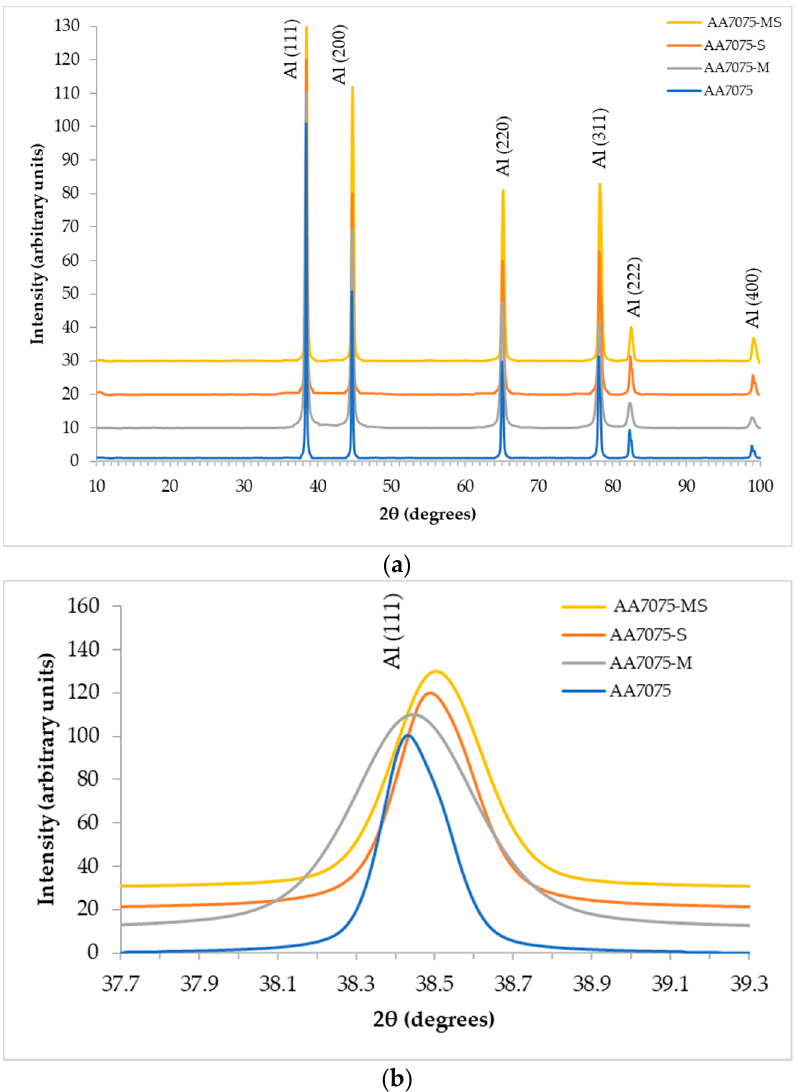
Figure 4. ( a ) XRD patterns of the AA7075 and AA7075-M powders and the corresponding sintered samples; ( b ) higher magnification of the region around the (111) peak. All patterns are normalized to the (111) peak. Table 2. Crystallite size D (nm), micro-strain ε (%), lattice parameter a 0 (nm) and dislocation den- sity δ (m − 2 ) powders and dense samples as deduced from the XRD